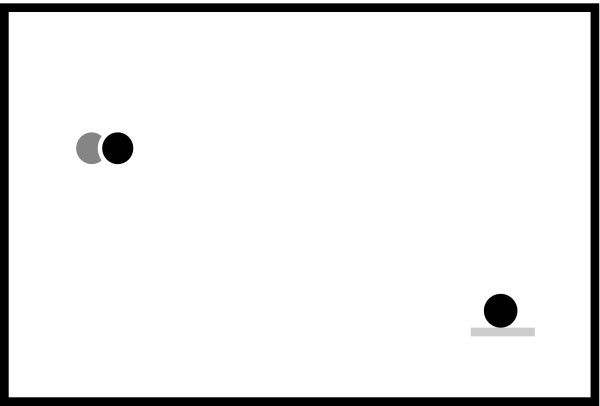
Human Machine Interface. Visual and audio interface used for the tracking task: Target position is represented by a red filled dot (black dot in the figure) and hand position is represented by a green filled dot (light gray dot in the figure) in a black screen (white in the figure). A visual distracter is also shown in the bottom right corner.